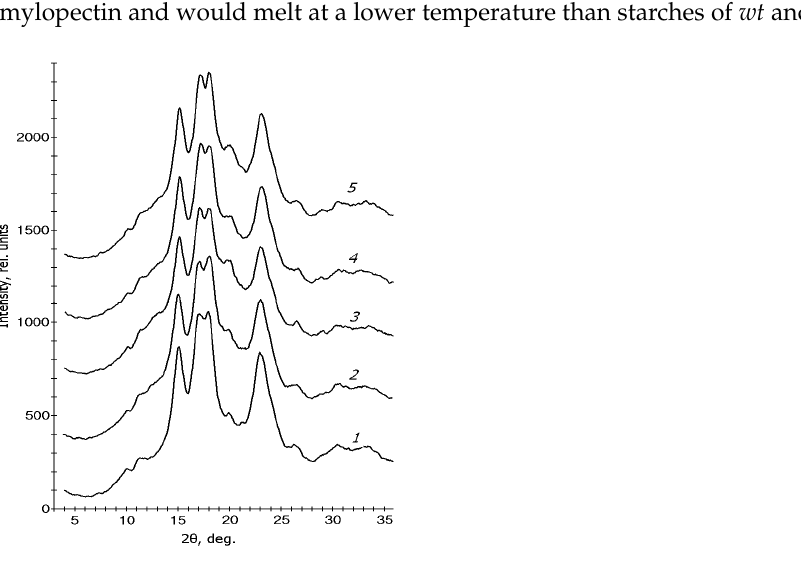
Figure 5. XRD patterns of starches of different maize genotypes and amylose content: 1— wx (0% the amylose content), 2—WT (17.5% amylose content), 3— su (25.5% amylose content), 4 and 5—“ ae ” (32% and 38% amylose content, correspondingly ) genotypes.